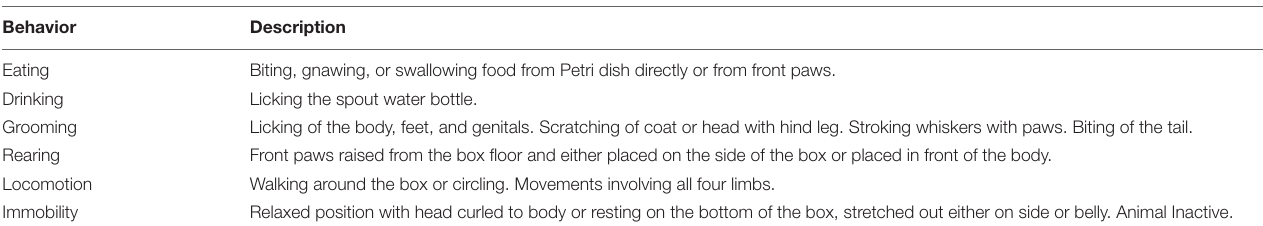
TABLE 1 | The behavioral categories used for behavioral analysis. Behavior